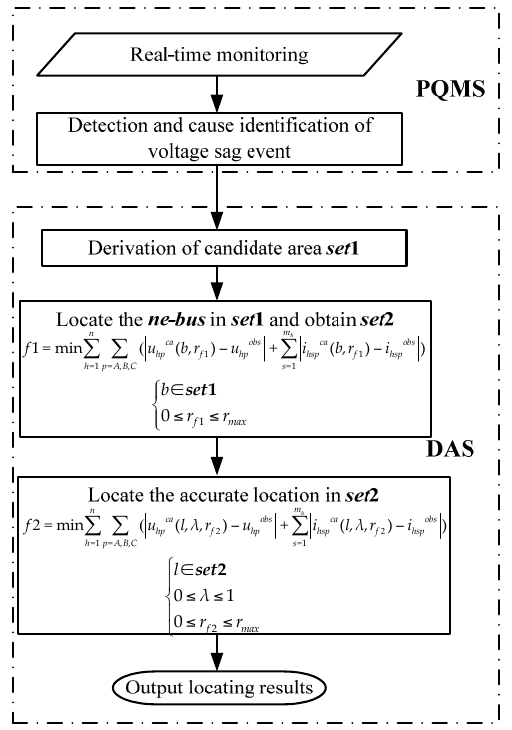
Figure 4. Main procedures of the proposed locating strategy.